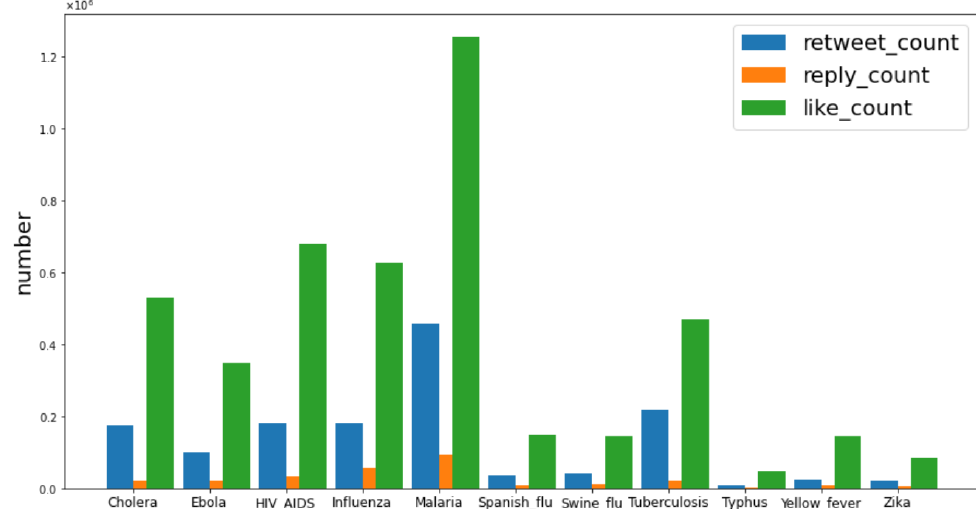
Figure 9. Retweets, replies, and likes.